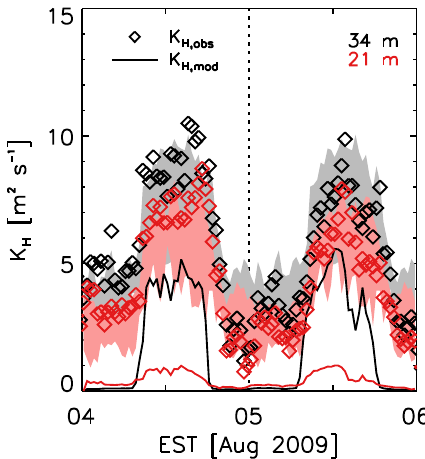
Fig. 2. Observed ( K H , obs , given by Eq. (8, diamonds)) and modeled ( K H , mod , given by Eq. ( 5), solid lines) time series of the turbulent exchange coefficient in the upper-canopy (20.6m, 0 . 9 h , red) and above the canopy (34m, 1 . 5 h , black) for 4–5 August 2009. Stan- dard deviations of the mean diurnal cycle of K H , obs for the sunny and partly sunny days (21, 29 July, 2, 4, 5, and 7 August) are shaded. K H , obs is calculated using sonic anemometer estimations of u ∗ and σ w (see Sect. 2.2.1).